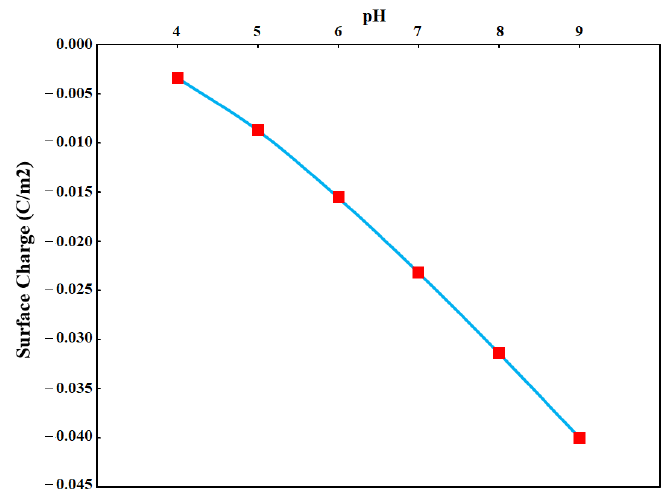
Figure 10. The estimated native oxide of OG-JFET surface charge equivalent to pH.